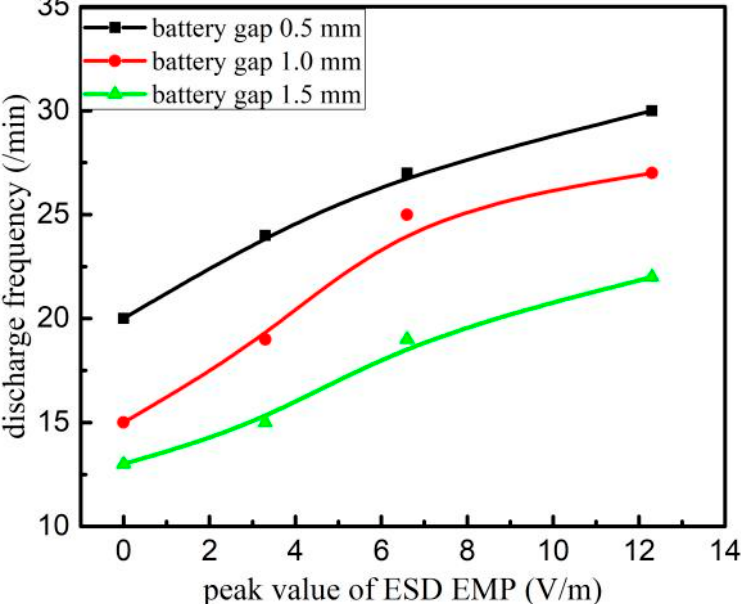
Figure 13. Comparison of discharge frequency of cell array under different electrode gap.